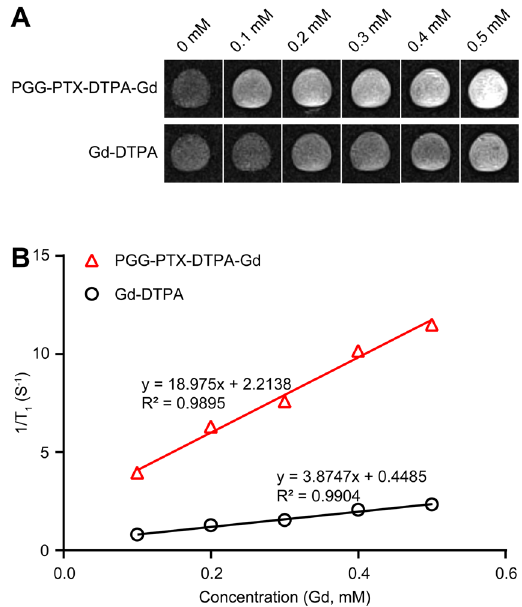
Figure 2. MR enhancement effects of PGG-PTX-DTPA-Gd NPs and free Gd-DTPA. ( A ) T 1 -weighted MR images of PGG-PTX-DTPA-Gd NPs and free Gd-DTPA solutions at 3 T MRI. ( B ) T 1 relaxivities coefficient of PGG-PTX-DTPA-Gd NPs and free Gd-DTPA characterized by 3 T MRI. PGG-PTX-DTPA-Gd NPs has higher contrast ability than free Gd-DTPA, as the images of PGG-PTX-DTPA-Gd NPs were much brighter than free Gd-DTPA at the same